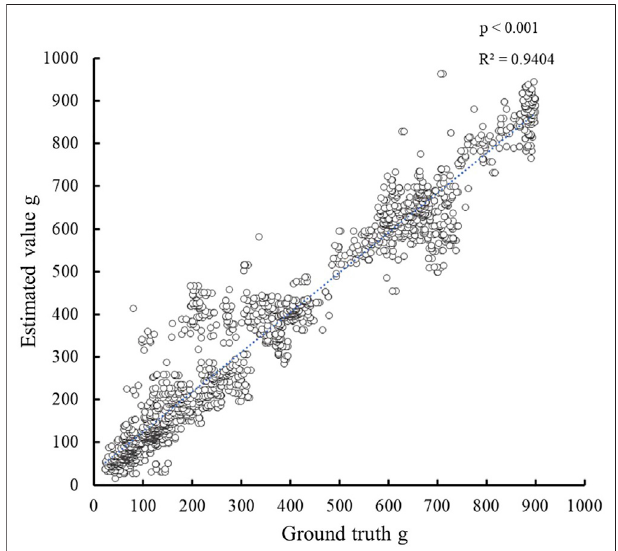
FIGURE 4 | Results of the relationship between measured and estimated values of the force of the index fi nger. The horizontal axis is the measured value acquired by the force sensor, and the vertical axis is the estimated value by FirstVR. p -value indicates the signi fi cant result of the correlation coef fi cient. The result shows a signi fi cant correlation.